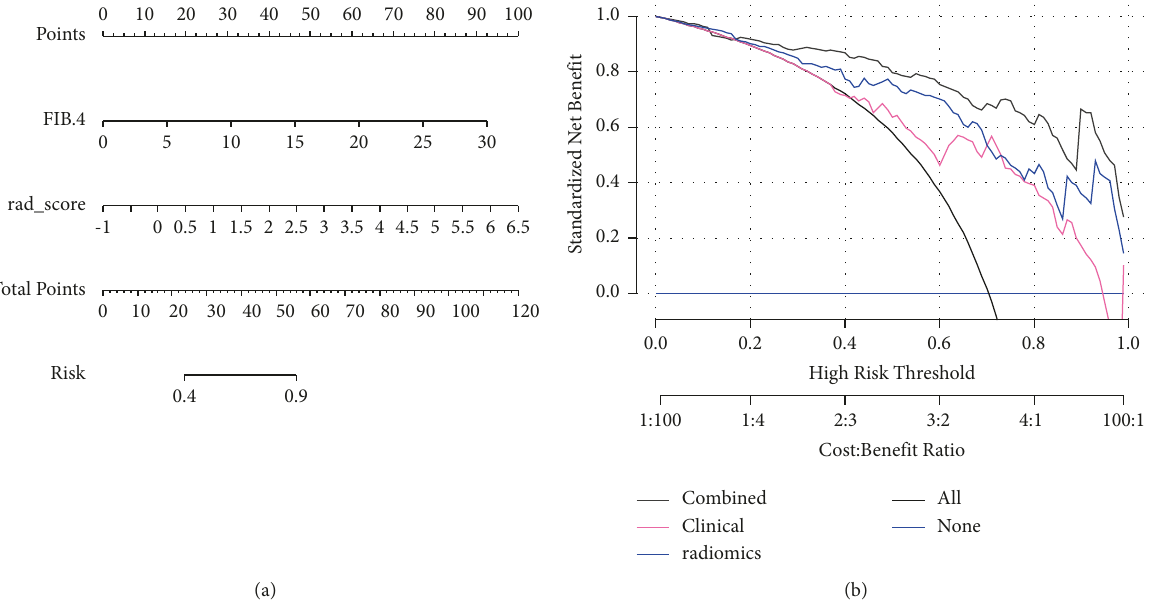
Figure 4: Nomogram (a) and decision curve (b). Decision curve showed more benefit than the treat-all (slash line) and treat-none (horizontal line) schemes and the combined model added more benefits than the radiomics and clinical